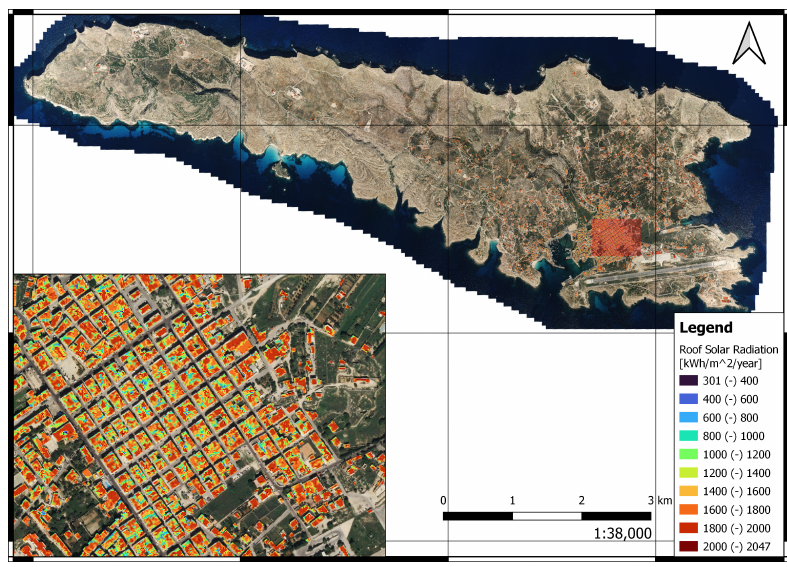
Figure 20. Solar radiation on Lampedusa